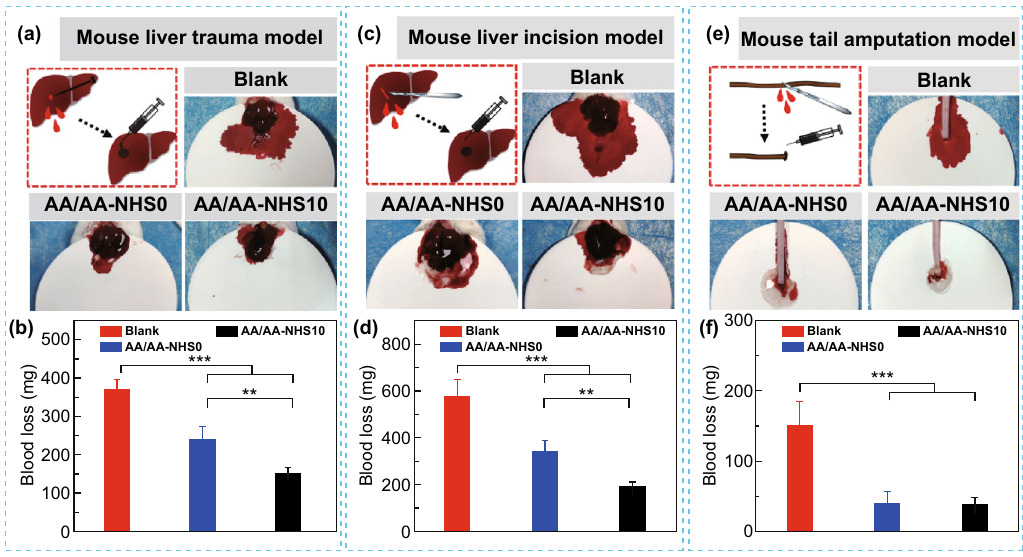
Fig. 4 a Schematic representation of the mouse liver trauma model. b Quantitative data of blood loss ( n = 6). c Schematic representation of the mouse liver incision model. d Quantitative data of blood loss ( n = 6). e Schematic representation of the mouse tail amputation model. f Quantita- tive data of blood loss ( n = 6). ** P < 0.01, *** P <